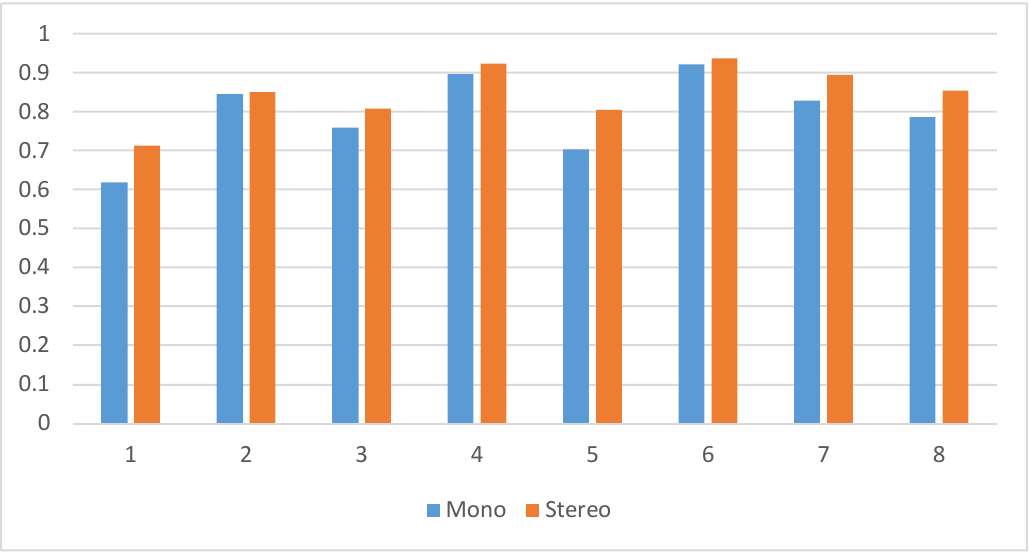
Figure 3. Mismatch accuracy of different types of cameras.